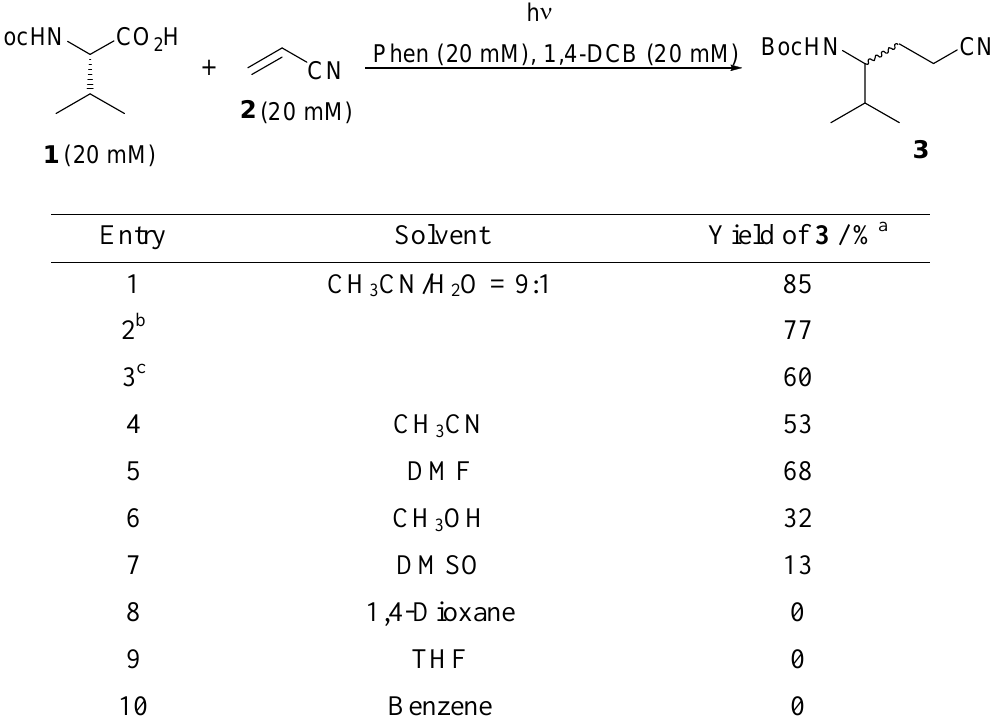
Table 1. Solvent effect on photoreaction of 1 and 2 via